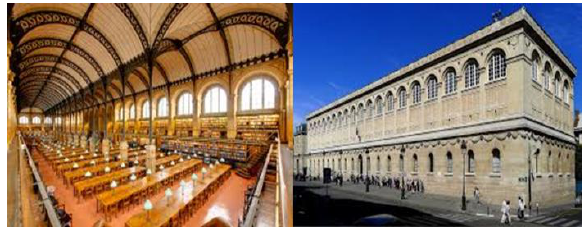
Figure 1 : Bibliothèque Sainte-Geneviève